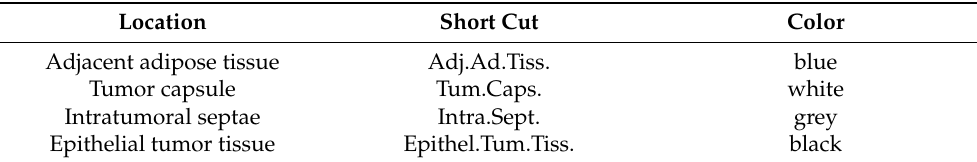
Table 2. Legend: color and assignments.